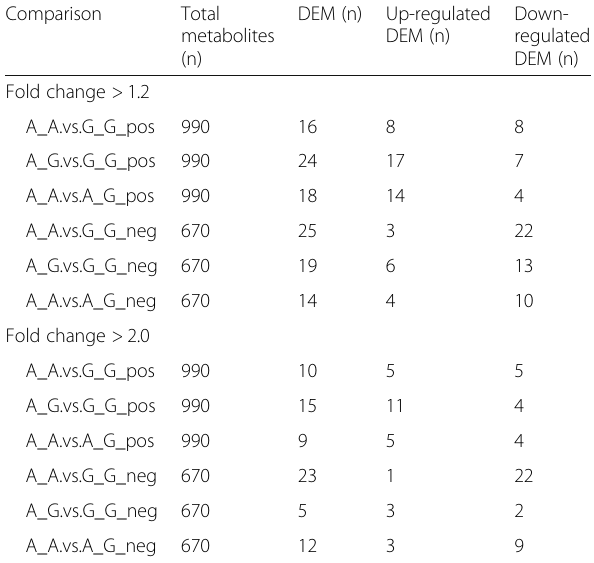
Table 1 Numbers of significantly differential expressed metabolites (DEM) ( P < 0.05, VIP >